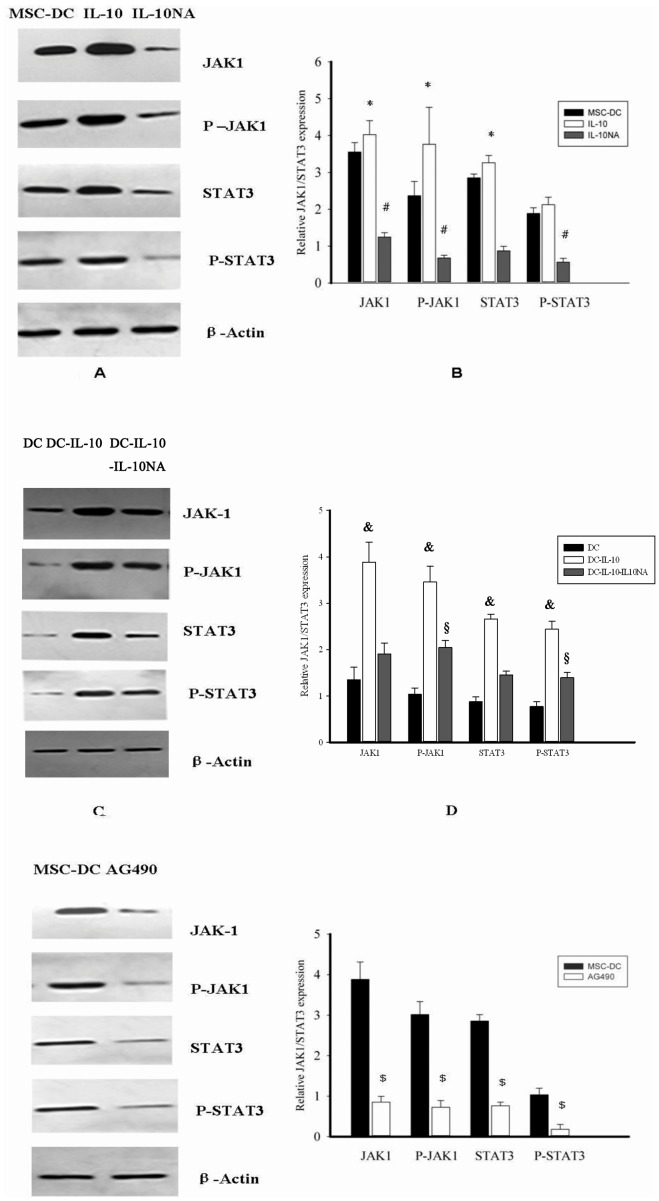
Protein expression of JAK1, P-JAK1, STAT3 and P-STAT3 of DCs in co-cultures of MSC-DC (MSC:DC ratio of 1∶10).(A) Western Blotting of the co-culture, without supplementation, or supplemented with, IL-10 or with IL-10NA (P<0.01); (B) Quantification by image analysis of the protein expression in the same conditions as (A); (C) Western Blotting of the co-culture, without supplementation, or supplemented withAG490 (P<0.01); (D) Quantification by image analysis of the protein expression in the same conditions as in (C). (E) Western Blotting of DC -IL-10 and DC- IL-10 -IL-10NA (P<0.01); (F) Quantification by image analysis of the protein expression in the same conditions as in (E). * P<0.05(IL-10 group versus MSC-DC group), # P<0.05(IL-10NA group versus MSC-DC group), $ P<0.05 (AG490 group versus MSC-DC group), & P<0.05 (DC- IL-10 group versus DC group), § P<0.05 (DCs- IL-10-IL-10NA group versus DC group).